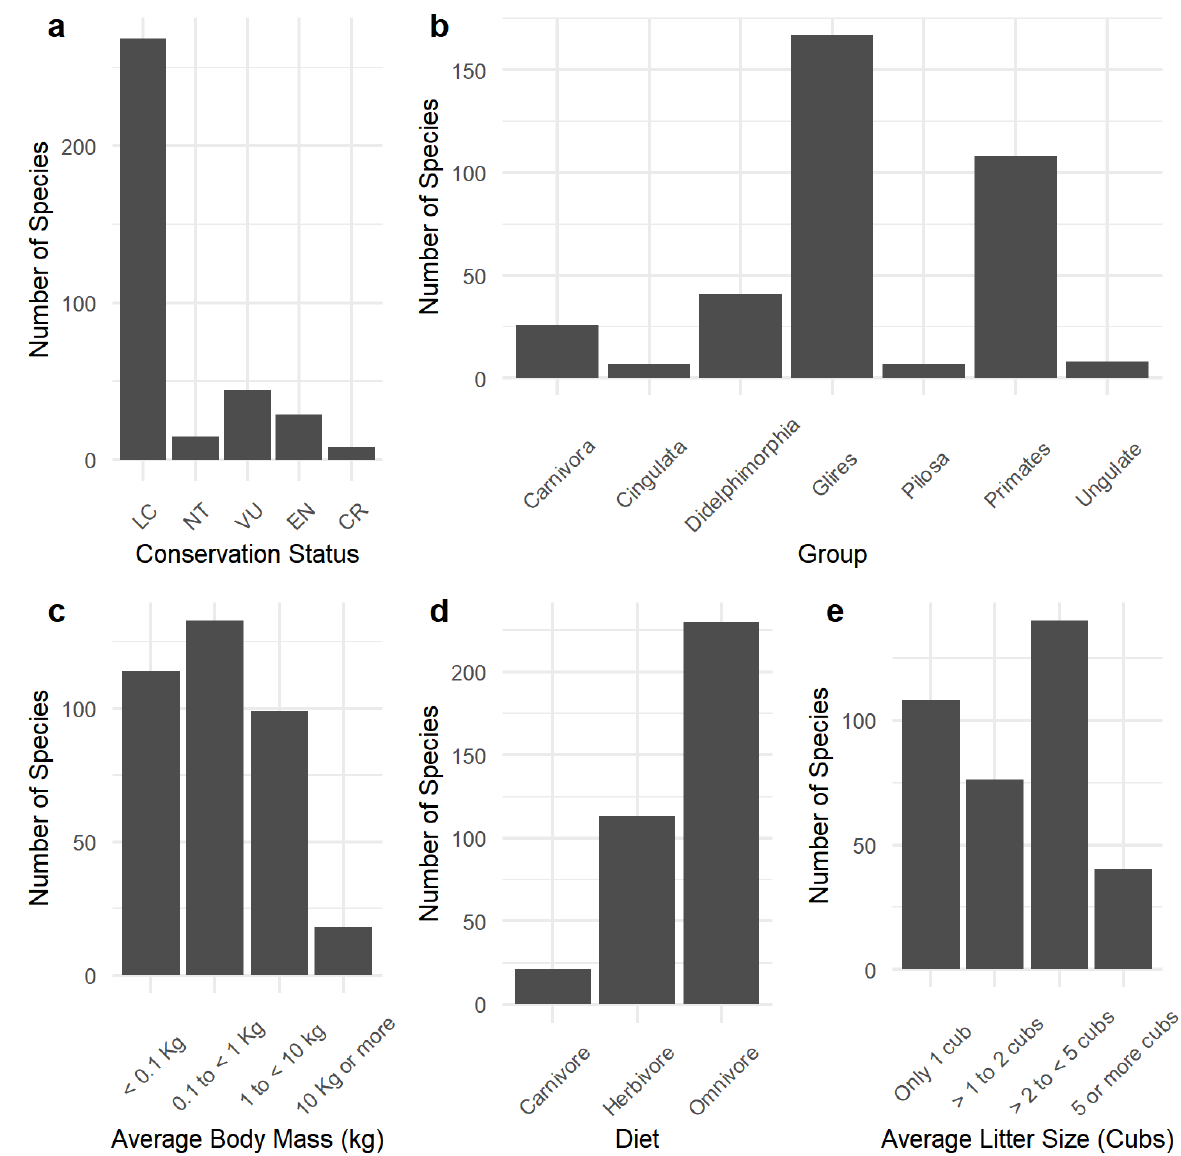
Figure 1. Number of Brazilian terrestrial mammal species according to: conservation status (a), taxonomic group (b), average body mass (kg) (c), diet (d), and average litter size (cubs)